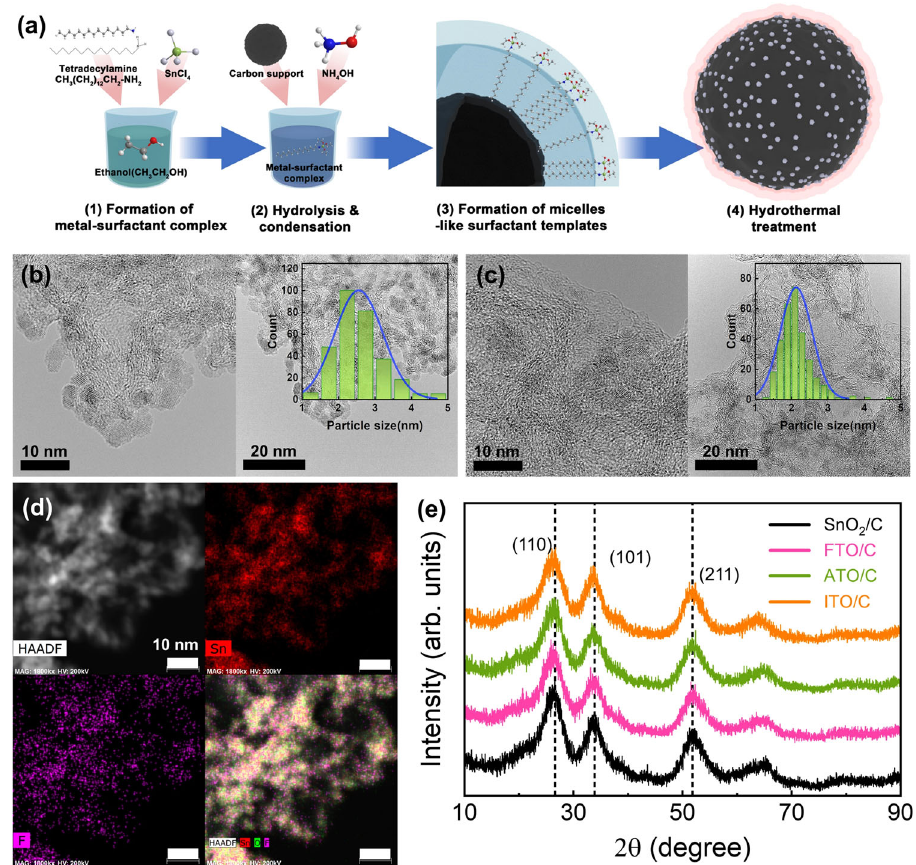
Fig. 1 Physical properties and synthetic scheme of Sn-based catalysts. a Synthetic pathway of well-dispersed Sn-based catalysts supported on carbon: (1) formation of metal-surfactant complex, (2) hydrolysis and condensation, (3) formation of micelle-like surfactant templates, and (4) hydrothermal treatment for recrystallization. HR-TEM images of b SnO 2 /C and c FTO/C catalysts (Inset: particle size distributions; average particle sizes and standard deviations fi tted with a Gaussian function). d HAADF-STEM image and its energy-dispersive X-ray spectroscopy (EDS) mapping images of Sn (red), F (magenta), and layered image combining all maps for FTO/C. The signal collecting time was 5 min. e Powder XRD spectra of Sn-based catalysts with various dopants. It indicated that the no phase change occurred by